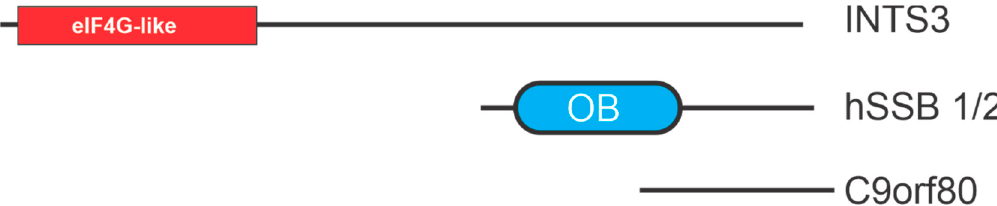
Figure 4. hSSB structural motifs. OB-folds are depicted as ovals with other motifs depicted as rectangles. eiF4G is a motif found in eukaryotic initiation factor 4G.